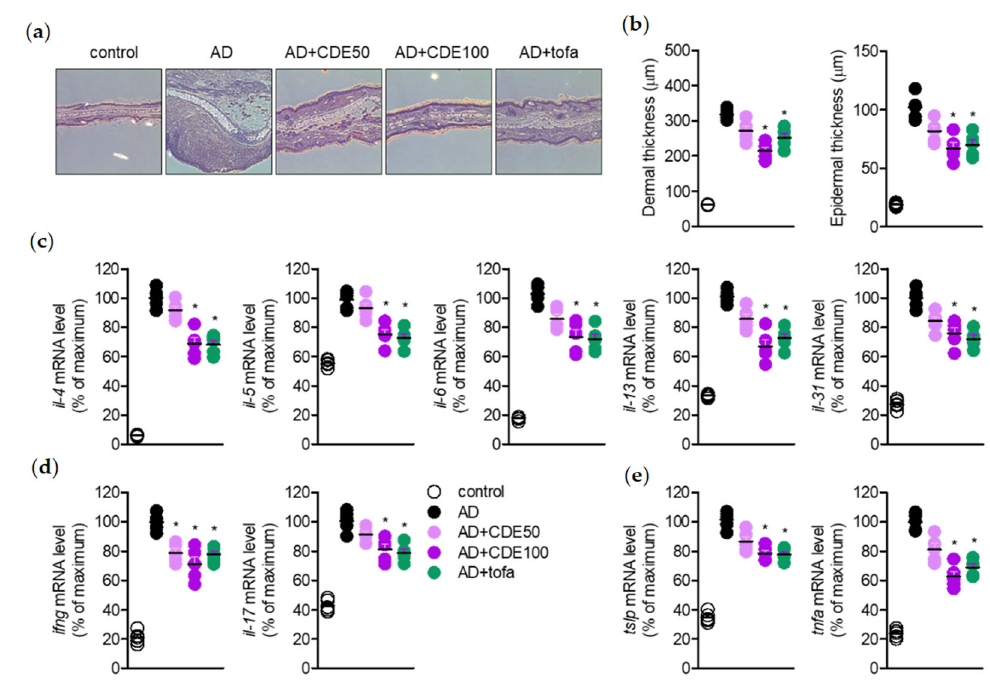
Figure 3. CDE modulates the mRNA levels of pro-inflammatory cytokines in ear tissues. ( a ) Representative histological stain images of mice ears (H&E staining). ( b ) Dermal and epidermal thickness of each mouse ear from histological stain images of mice ears. ( c – e ) The mRNA level of pro-inflammatory cytokines in ear tissues was detected by real-time quantitative PCR. The groups in the experiment were as follows: mock, mice group treated with PBS; AD, mice group with induced atopic dermatitis by application of mite extract and 1% DNCB; AD + CDE 50 mg/kg, mice group with induced atopic dermatitis by application of mite extract and 1% DNCB; AD + CDE 100 mg/kg, tofacitinib was used as a positive control. Results are expressed as mean ± SEM of five mice (* p < 0.05).